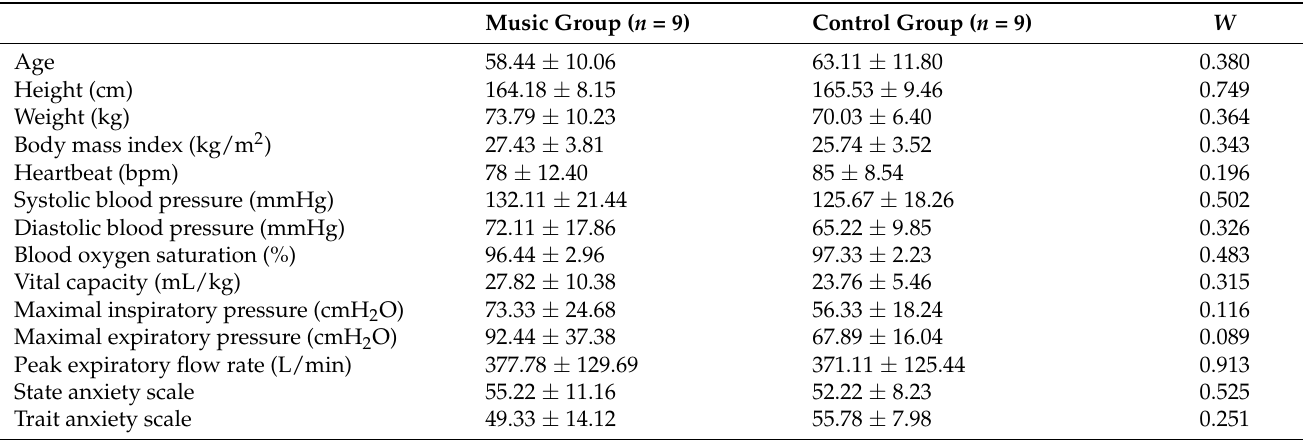
Table 2. Examination of the differences between the normal distribution and the two groups before the trial.